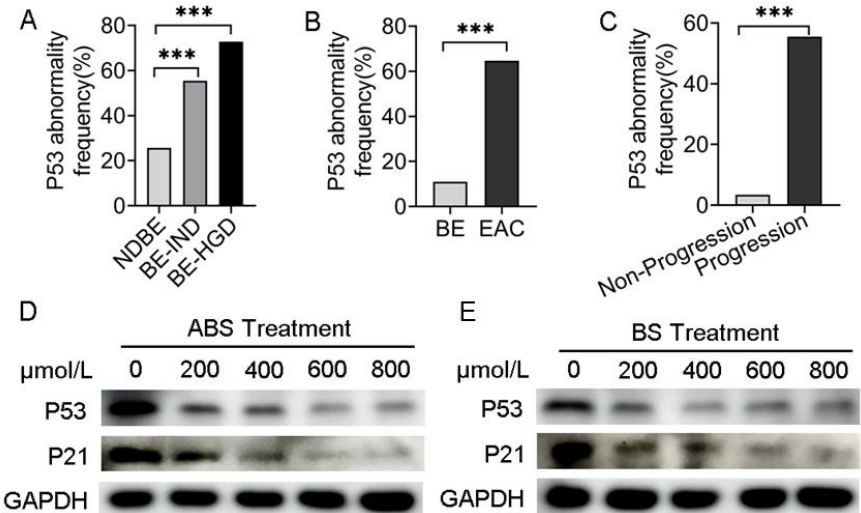
Figure 1. P53 deficiency is associated with the progression of BE and EAC. ( A ) P53 abnormal frequency in NDBE, BE-IND and BE-HGD. ( B ) P53 abnormal frequency in BE and EAC. ( C ) P53 abnormal frequency in progressive and non-progressive EAC. ( D ) P53 and P21 protein expression after treatment with ABS titration in HET1A cells after 72 h. ( E ) P53 and P21 protein expression after treatment with BS titration in HET1A cells after 72 h. BE: Barrett’s esophagus; EAC: esophageal adenocarcinoma; NDBE: nondysplastic BE; BE-IND: BE indefinite for dysplasia; BE-HGD: BE with high-grade dysplasia; ABS: acidic bile salt medium; BS: neutral bile salt medium. Data were statisti- cally analyzed using the student t test. *** p <